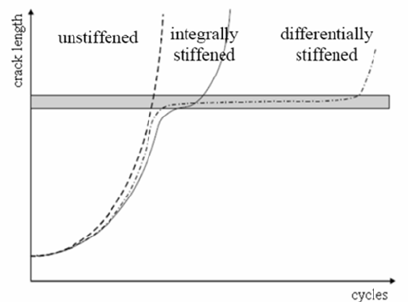
Figure 1: Comparison between the several design solutions according the “crack arrest” method.